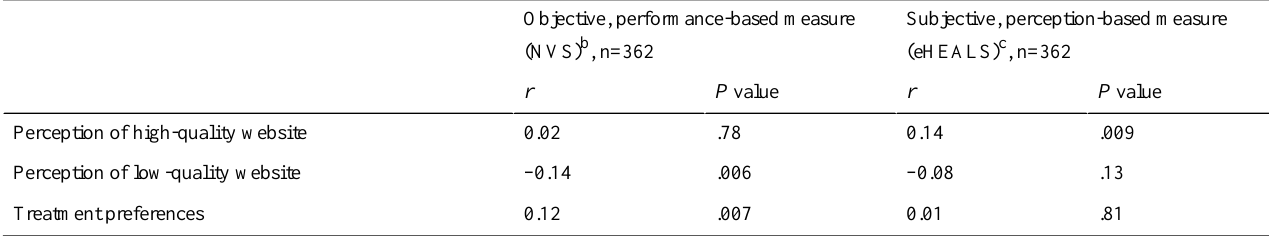
Table 1. Correlations between two health literacy measures and perception of website quality/choice of depression treatment.a